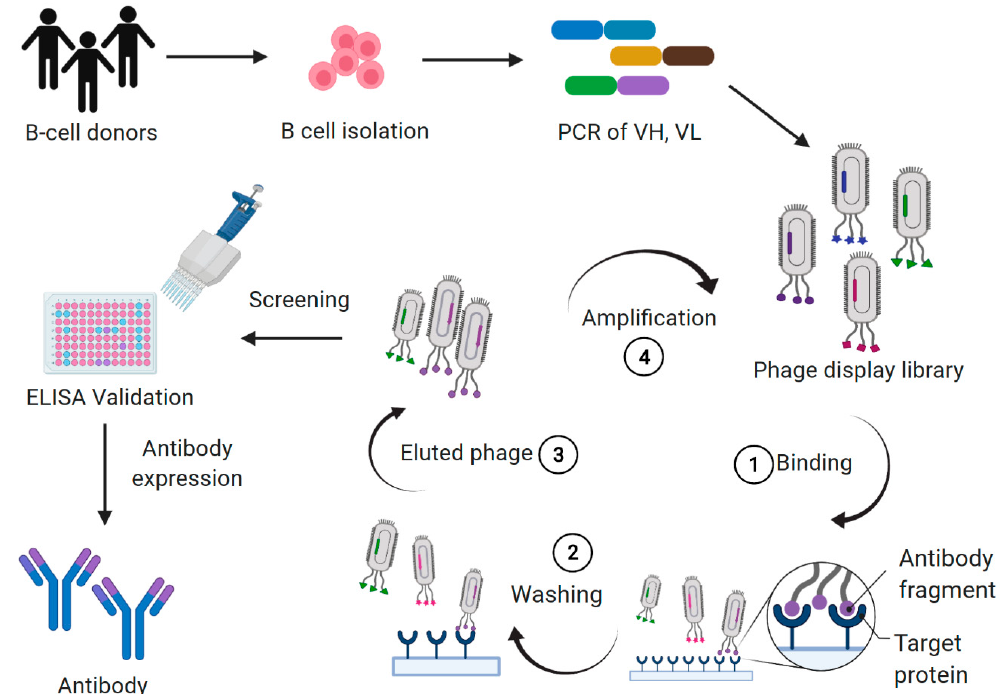
Figure 1. The illustration of phage combinatorial antibody libraries. Lymphocyte cells are collected from humans, e.g., naïve, cancer patients, disease survivors carrying antibodies with unique characteristics, or immunized animals. The RNA of B cells is prepared and transcribed into single-stranded cDNA that is used as the source for PCR amplification of the heavy chain (VH) and the light chain (VL) genes. Variable genes are cloned into phagemid vectors as antibody fragments, then produced to phage combinatorial antibody libraries in E. coli bacteria. The target protein is immobilized on immunotubes for selection. Specific binding phages displaying antibodies are enriched over several selection rounds by 1. binding, 2. washing, 3. elution, and 4. phage amplification. After 3–5 rounds of biopanning, the specific phage binders are screened by ELISA, then DNA sequences are analyzed and cloned into appropriate expression vectors to produce antibodies, or various antibody formats for functional